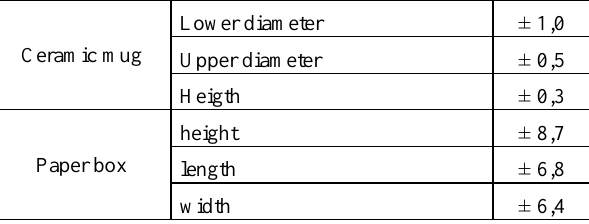
Table 5. Comparison of the obtained average errors of the single observation in the accuracy analysis of the data collection The obtained average errors of the single observation obtained data with comparison method measured lengths of chosen elements on the objects and models are from ± 0,4 mm to ± 9,0 mm. The largest average errors had the snail figurette in three lengths, respectively ± 9,0 mm; ± 5,0 mm and ± 2,9 mm, for the paper box the errors were more than ± 6 mm (± 8,7mm; ± 6,8mm; ± 6,4mm). For the other objects, the values of the errors didn’t exceed ±